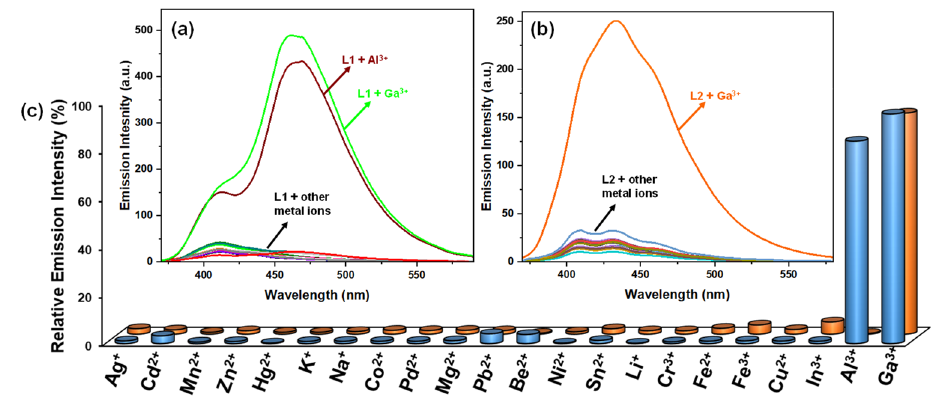
Figure 4. Emission spectra of chemosensors ( a ) L1 (c, 20 μM) and ( b ) L2 (c, 20 μM) in EtOH in the presence of assorted metal ions (c, 50 μM). ( c ) Bar diagram showing the relative change in the emission intensity of L1 (blue bars) and L2 (orange bars) in the presence of assorted metal ions (c, 50 μM).